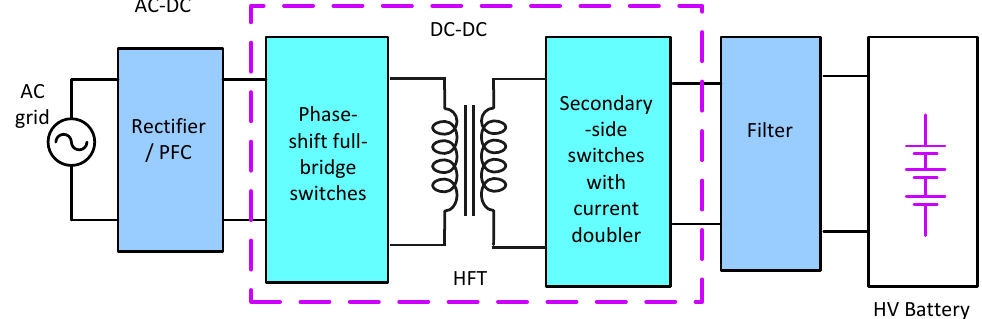
Figure 1. Block diagram of the conventional electric vehicle (EV) on-board charger.